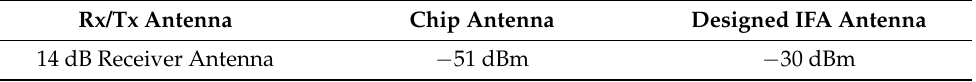
Table 1. Comparison of signal strength measurement with chip antenna and proposed IFA